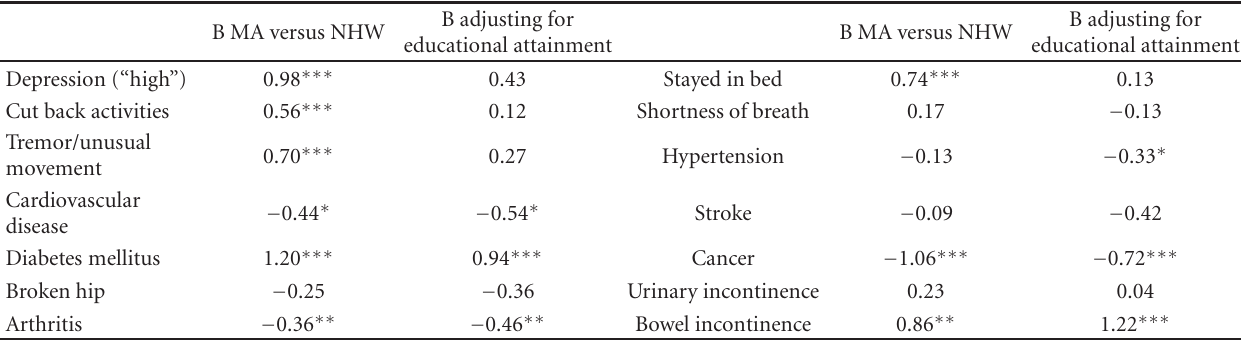
Table 3: Logistic regression analysis predicting “high” depressive symptomatology and 13 health-related conditions by Mexican American ( N = 799) versus non-Hispanic White ( N = 353) ethnicity, adjusting for educational attainment a